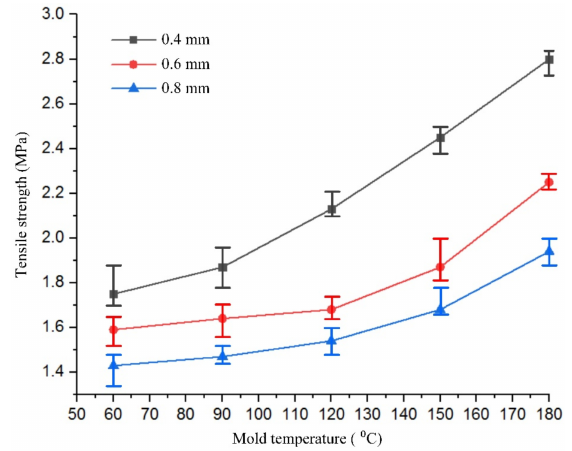
Figure 20. Tensile strength of products with di ff erent thicknesses and di ff erent mesh area